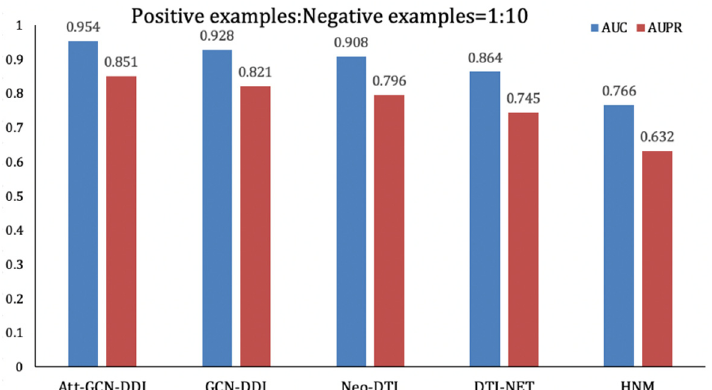
Figure 4. Comparison results of Att-GCN-DDI and previous methods in the first scenario.